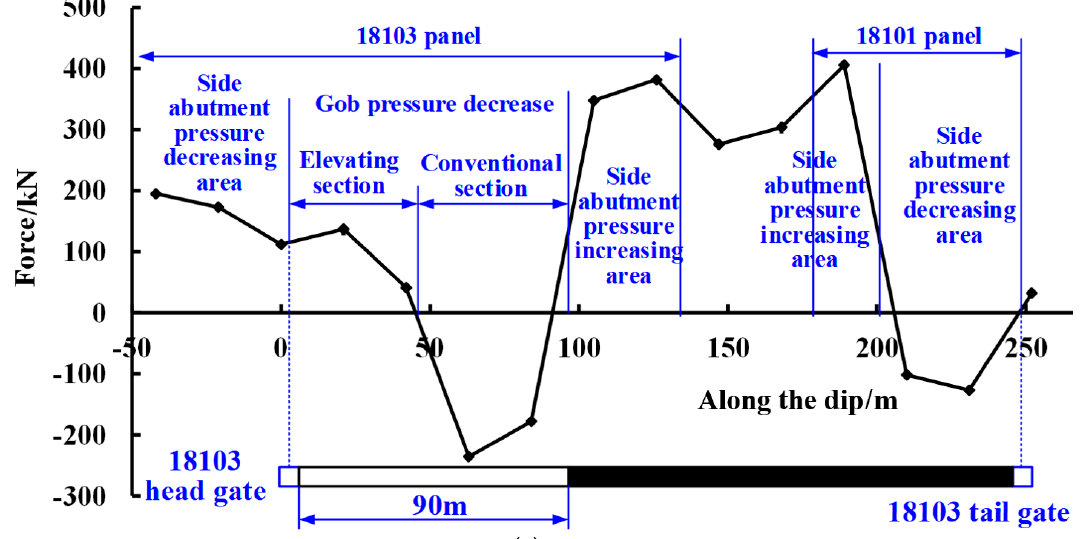
Figure 13. Extraction is finished.